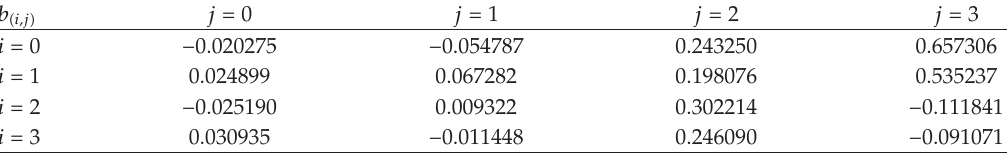
Table 1: The coe ffi cients of a nonseparable orthogonal low-pass wavelet filter.